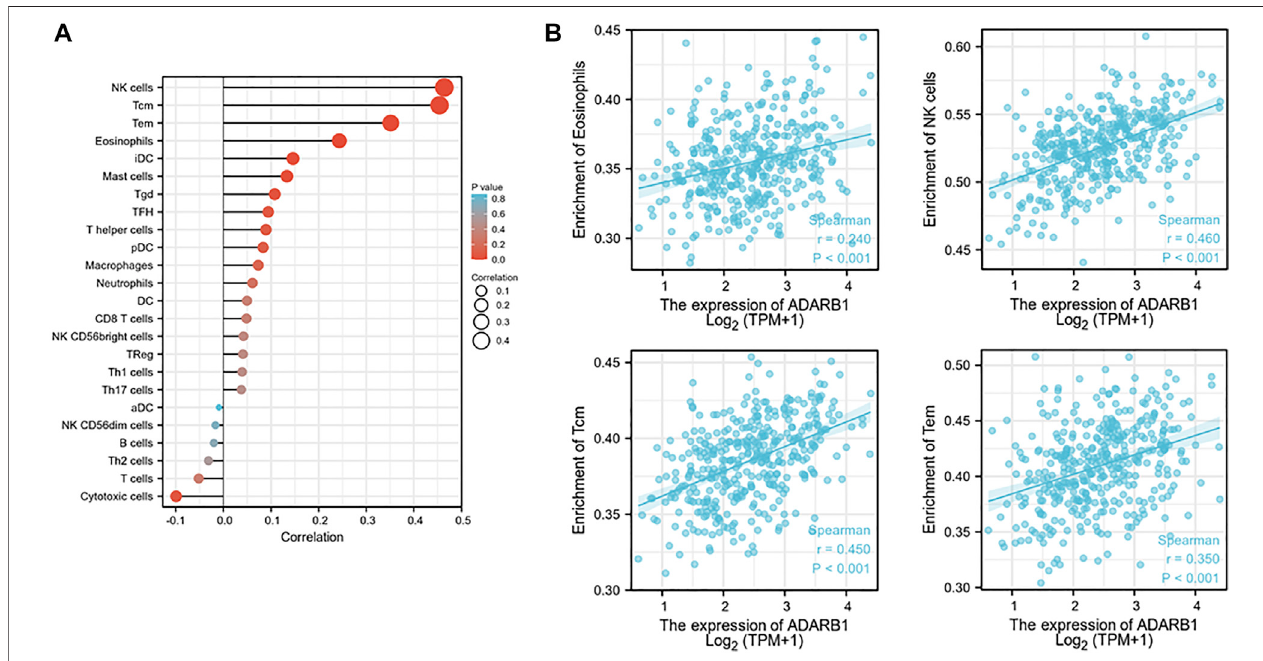
FIGURE 8 | Correlation of ADARB1 expression with tumor-in fi ltrating lymphocytes in OC. (A) The correlation between ADARB1 expression and tumor-in fi ltrating lymphocytes. (B) The top four tumor-in fi ltrating lymphocytes showing the most signi fi cant correlations with ADARB1 expression. Supplementary Figure S1 . Immunohistochemistry was used to examine the ADARB1,p-AKT, CXCL12 and KDR expression in ovarian cancer tissue and paired adjacent tissue (magni fi cation 200 × ).